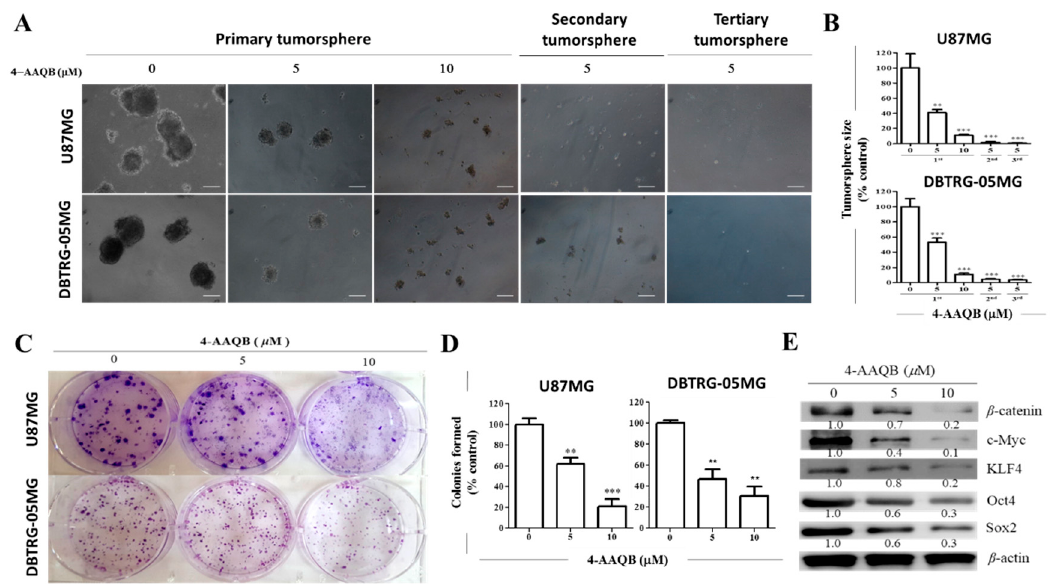
Figure 6. 4-AAQB markedly inhibits the stem cell-like phenotype of U87MG and DBTRG-05MG cells. ( A ) Representative photo-images and ( B ) graphical quantification showing 4-AAQB significantly reduce the size and number of U87MG and DBTRG-05MG primary, secondary, and tertiary generation tumorspheres formed. Original magnification = 200×. ( C ) Representative photo-images and ( D ) graphical representations of 4-AAQB effect on the ability of U87MG and DBTRG-05MG cells to form colonies; ( E ) The dose-dependent inhibitory effect of 5–10 M 4-AAQB treatment on the expression levels of β -catenin, c-Myc, KLF4, Oct4, and Sox2 proteins in DBTRG05MG cells shown in a representative Western blot data. β -actin served as loading control. * p < 0.05, ** p < 0.01, *** p < 0.001; All data is representative of experiments performed 4 times in triplicates.